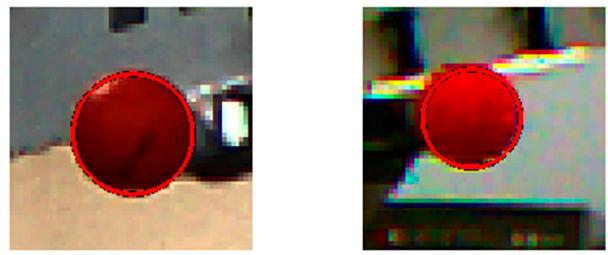
Figure 5. Two CRCHT search windows.